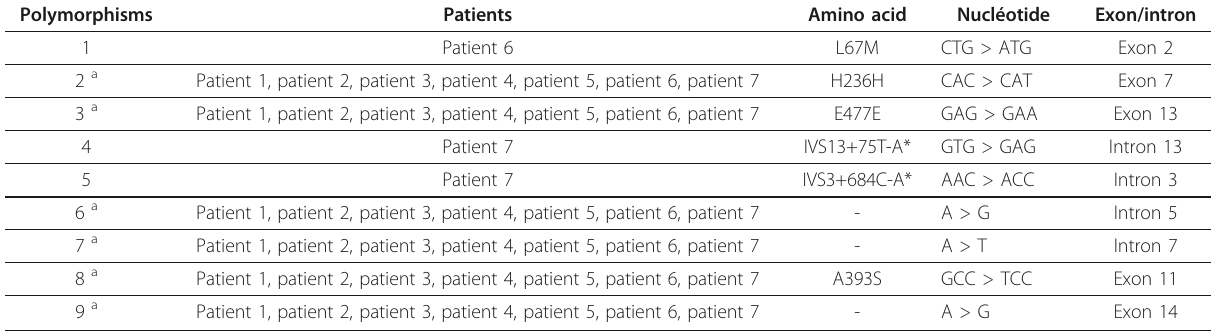
Table 2 GALNS gene polymorphisms in Tunisian patients Polymorphisms